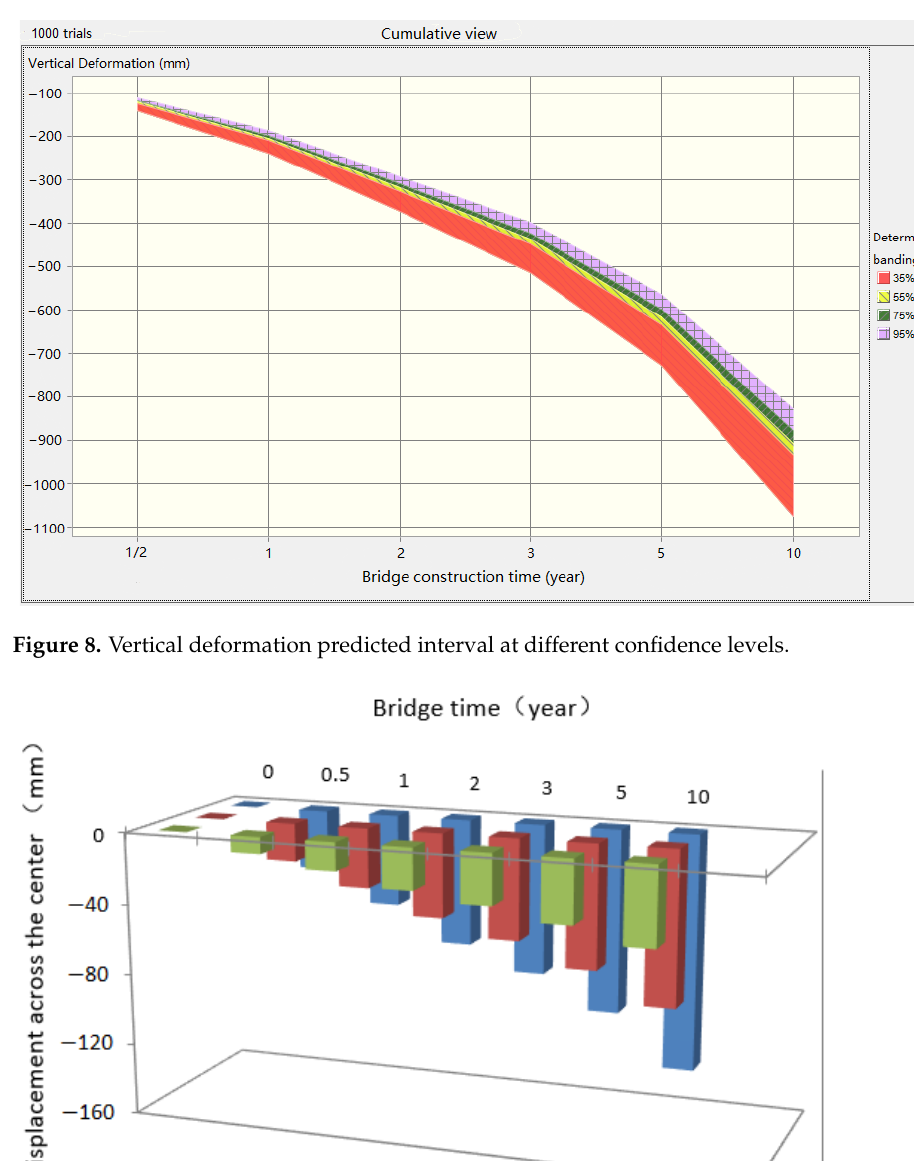
Figure 9. Prediction of vertical deformation at the mid-span of the main span (unit: mm).